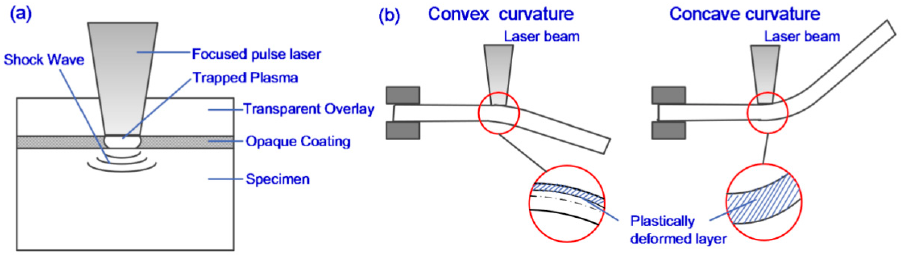
Figure 40. ( a ) Schematic diagram of laser peening and ( b ) bending out of plane with concave and convex curvatures (reproduced with permission from [377]; copyright© 2021 Elsevier B.V.).